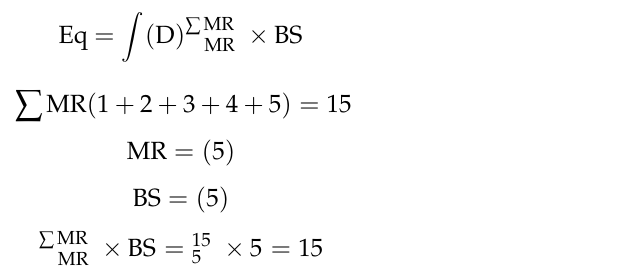
Table 3. The determination of Behavior scores of the Influence of IoTs based on faster data collec- tion.